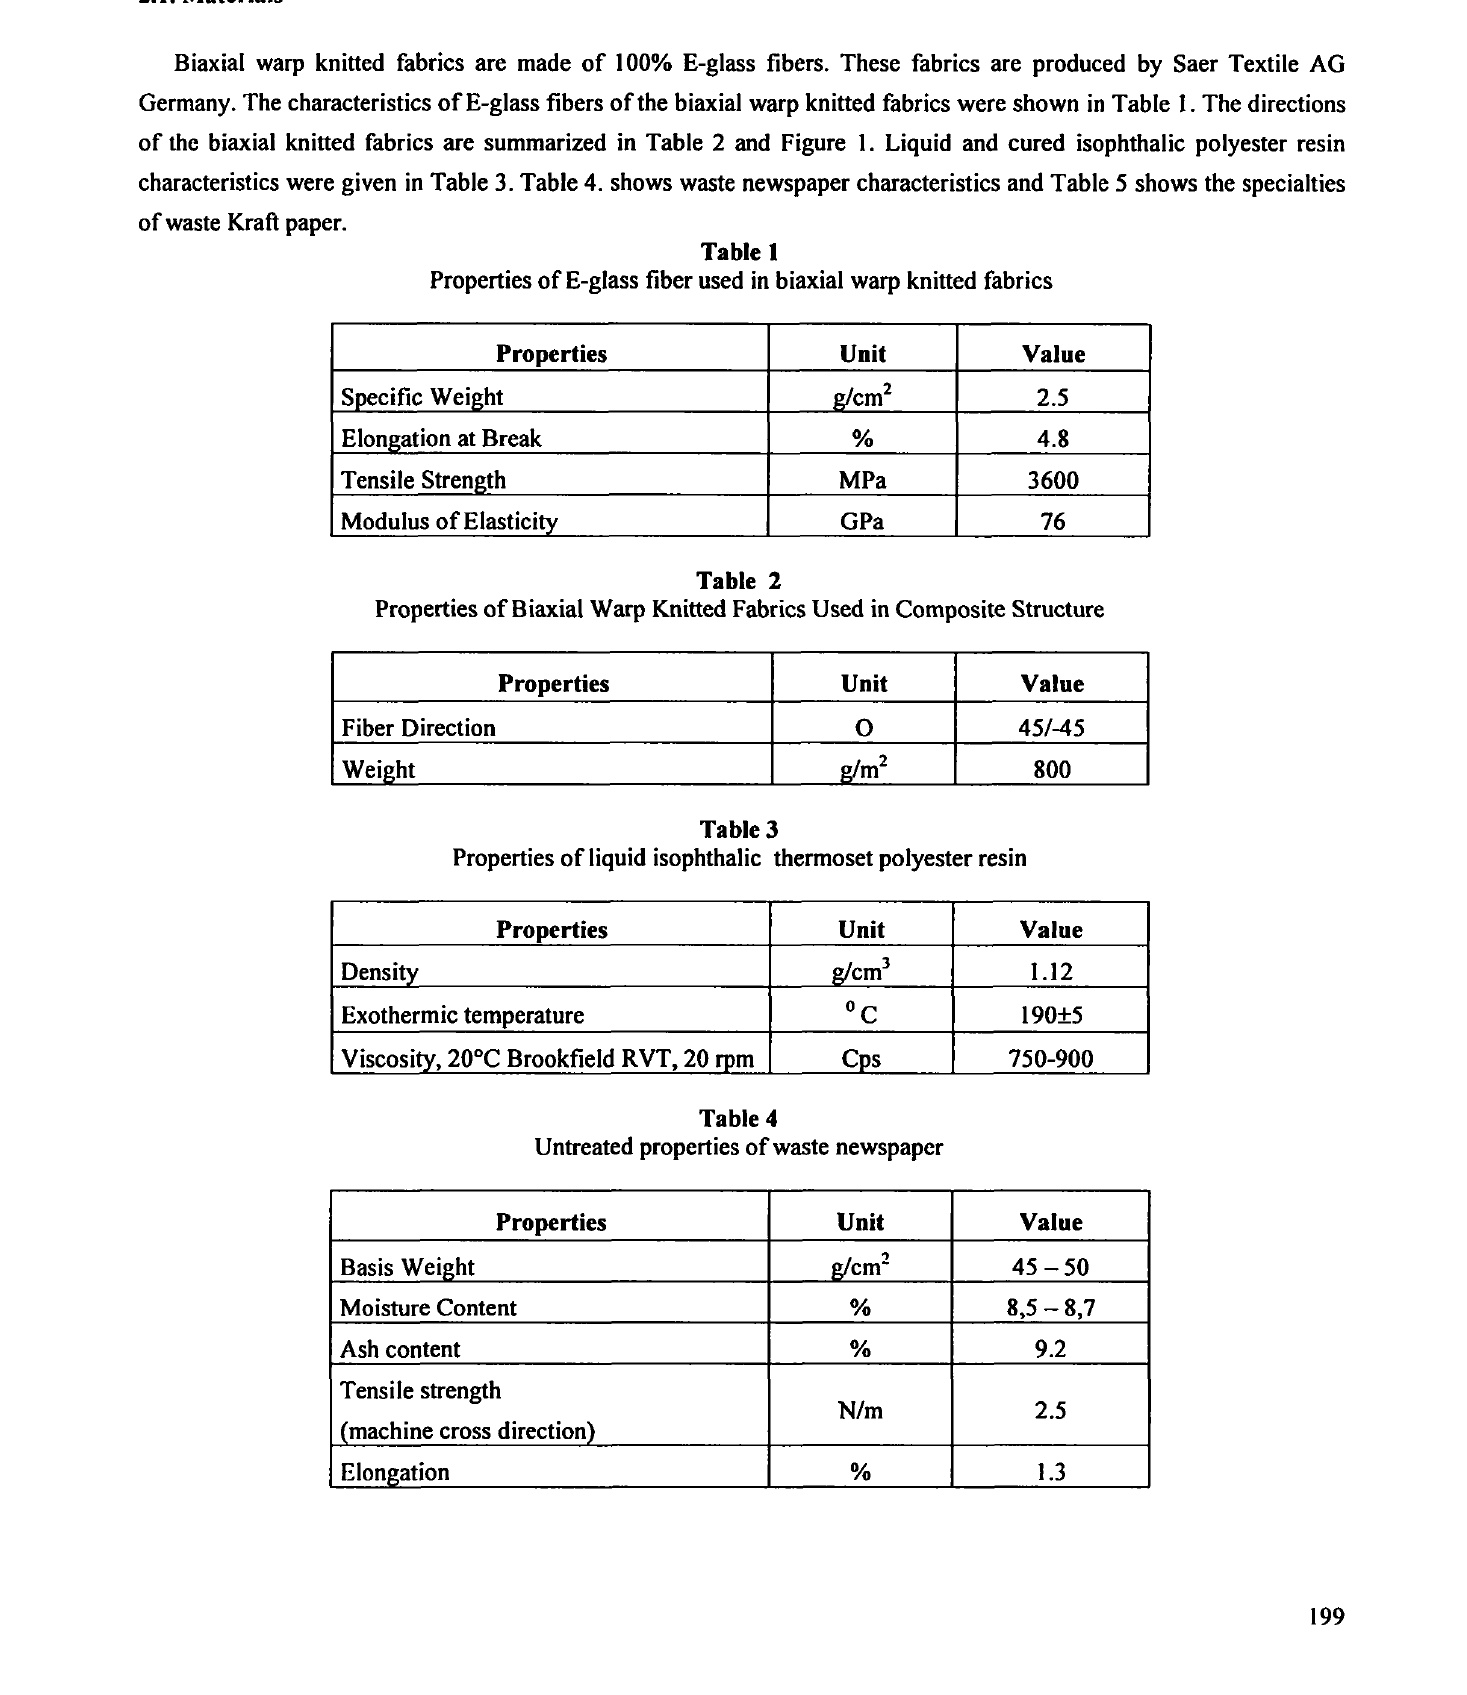
Properties of Biaxial Warp Knitted Fabrics Used in Composite